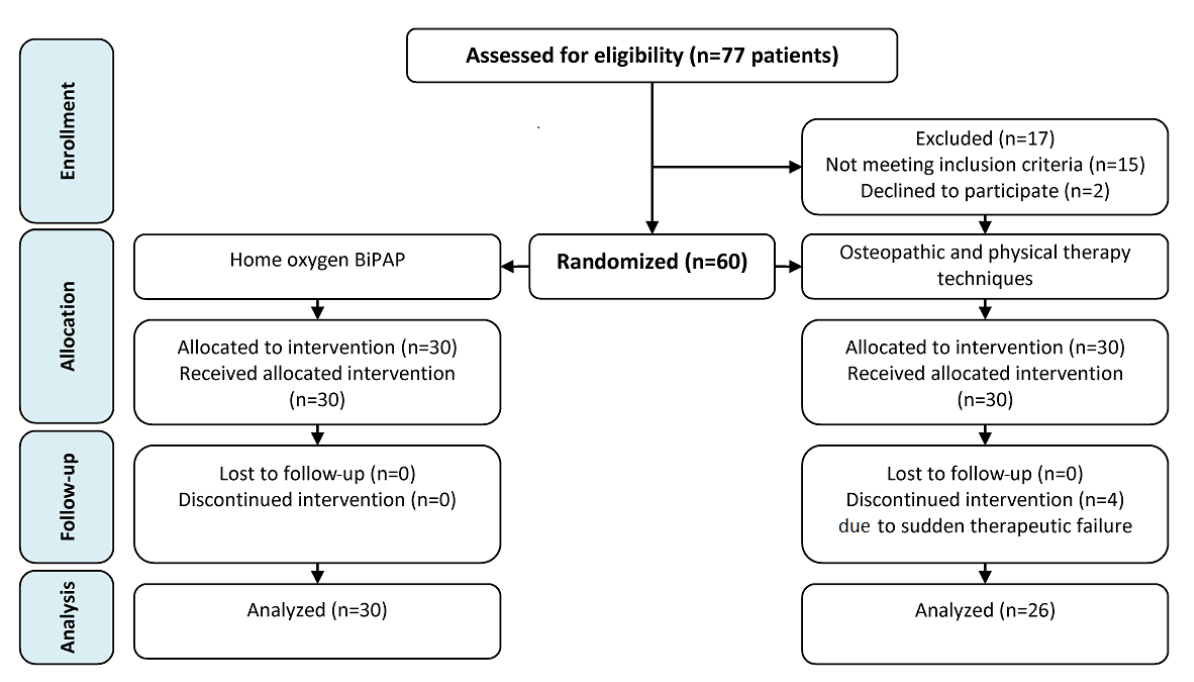
Figure 1. CONSORT flow diagram. BiPAP: bilevel positive airway